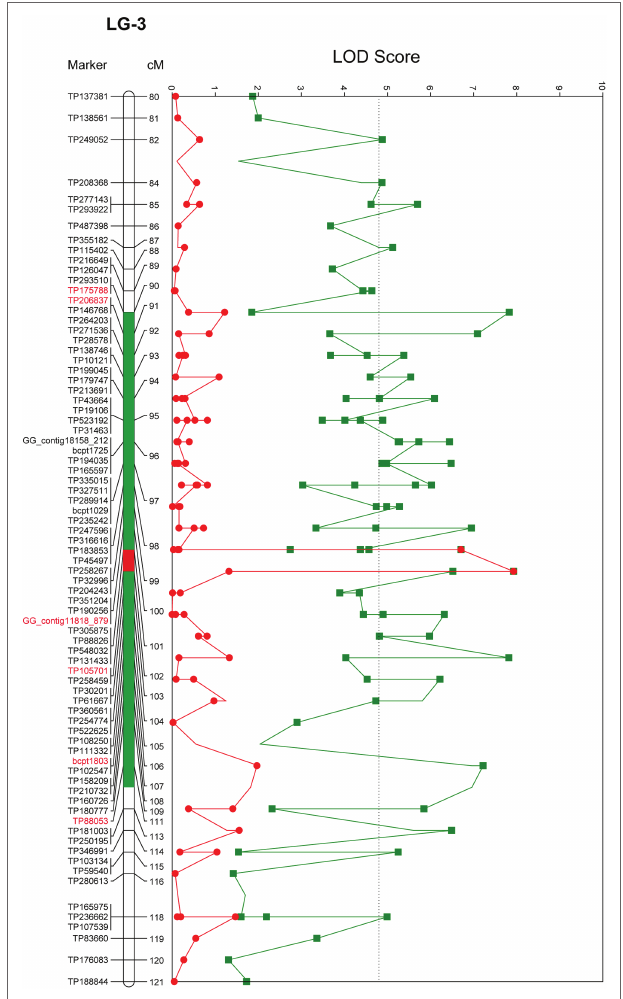
FIGURE 3 | Localization of QTLs for PWD resistance identified in resistant variety “Namikata 73.” Only the area around the QTL was detected are displayed, and the red marker is located in the PWD1 interval. The line trace in green shows the LOD score determined by interval mapping. The line trace in red shows the LOD score determined by multiple QTL mapping. Green tones and red tone as colored bars indicates a 1-LOD confidence interval of interval mapping and multiple QTL mapping. The genome-wide p = 0.05 threshold for the data set was determined to be LOD = 4.8. The genetic linkage maps are in centimorgans